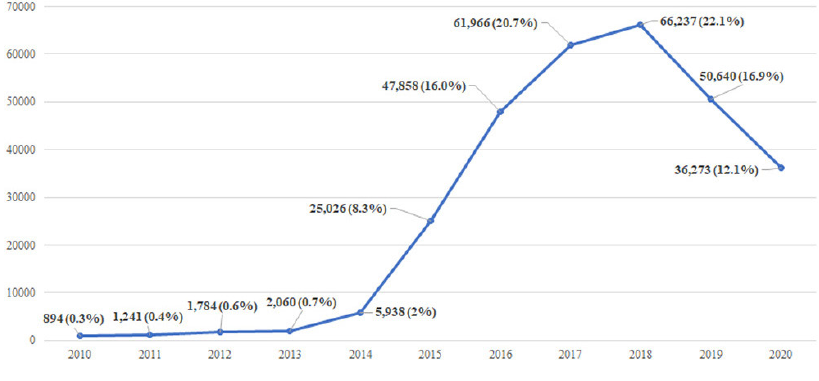
Fig. 5. Annual tweets over the years 2010–2020